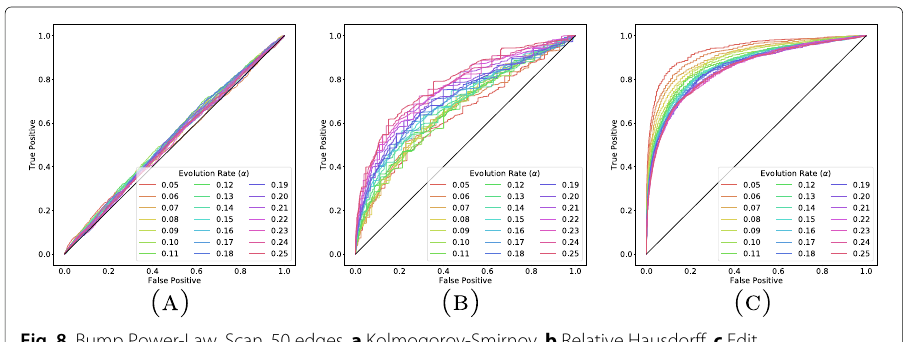
Fig. 8 Bump Power-Law, Scan, 50 edges. a Kolmogorov-Smirnov. b Relative Hausdorff. c Edit